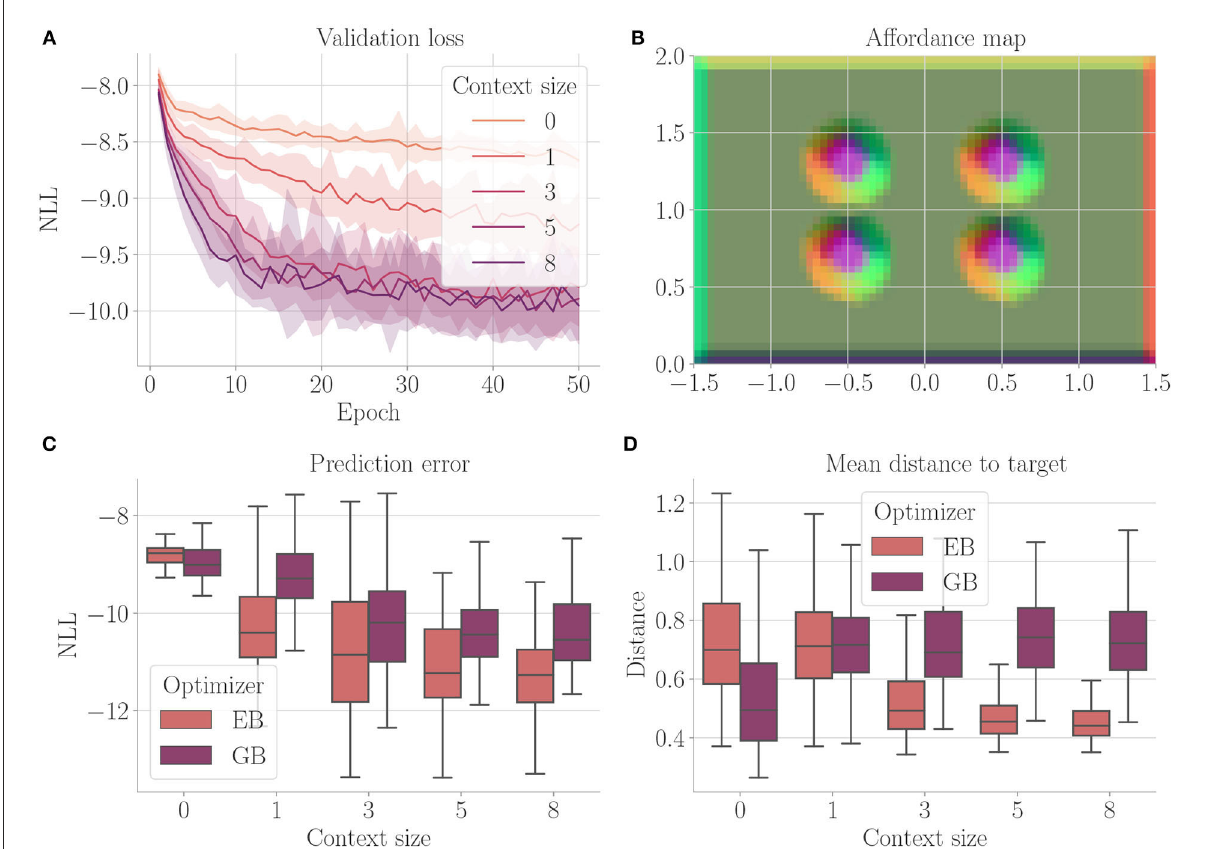
FIGURE4 Results for Experiment I–Obstacle avoidance (Section 4.3). For each setting, the results are aggregated over 25 differently initialized models which each performed 4 goal-directed control runs for 200 time steps. The box plots show the medians (horizontal bars), quartiles (boxes), and minima and maxima (whiskers). Data points outside of the range defined by extending the quartiles by 1.5 times the interquartile range in both directions are ignored. EB is short for evolutionary- and GB for gradient-based active inference. (A) Validation loss during training. It is the negative log-likelihood of the actual change in position in the transition model’s predicted probability distribution. Shaded areas represent SDs. (B) Exemplary affordance map for context size 8 . To generate this map, we probed the environmental map at every sensible location, applied the vision model to each output, performed dimensionality reduction to 3 via PCA, and interpreted the results as RGB values. (C) Prediction error during goal-directed control. It is the negative log-likelihood of the actual change in position in the transition model’s predicted probability distribution. (D) Mean distance to the target during goal-directed